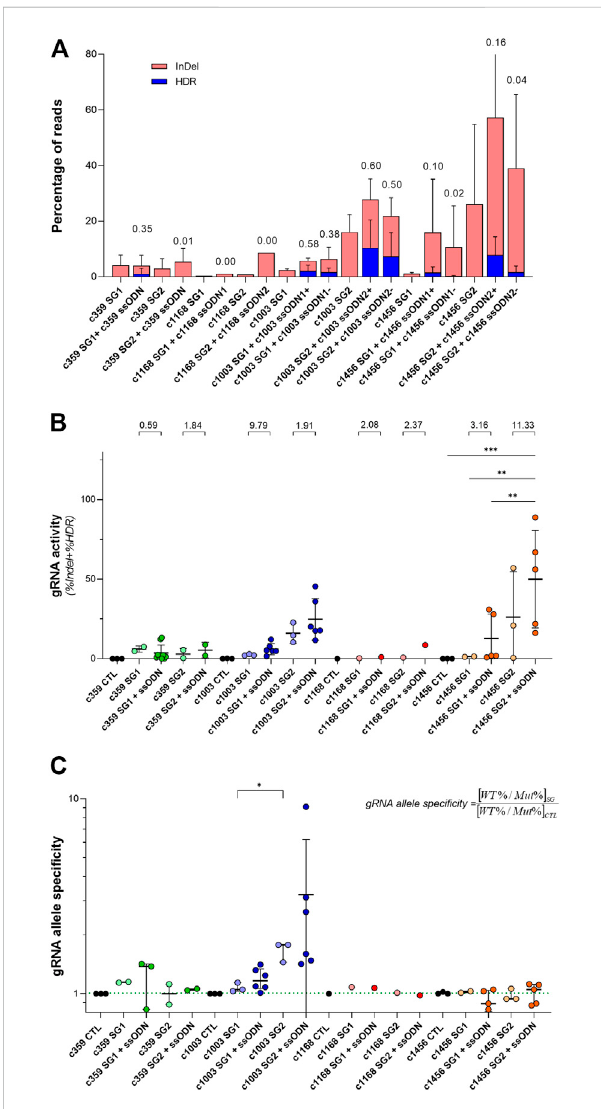
FIGURE 3 Analysis of the activity and mutation-speci fi city of the